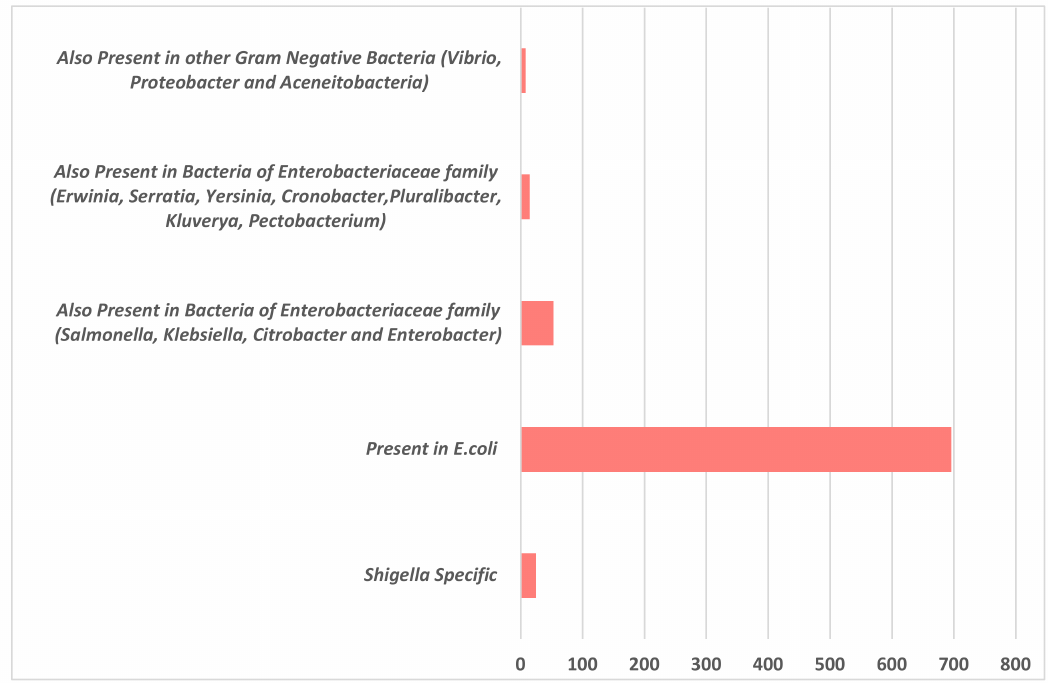
Figure 2. NCBI Protein BLAST of the 721 hypothetical proteins (HPs) present in Shigella flexneri 1c strain showed that these HPs were also present in other Gram-negative bacteria, majority of them being present in di ff erent pathogenic and non-pathogenic E. coli strains, followed by other Gram-negative pathogenic bacteria belonging to the family of